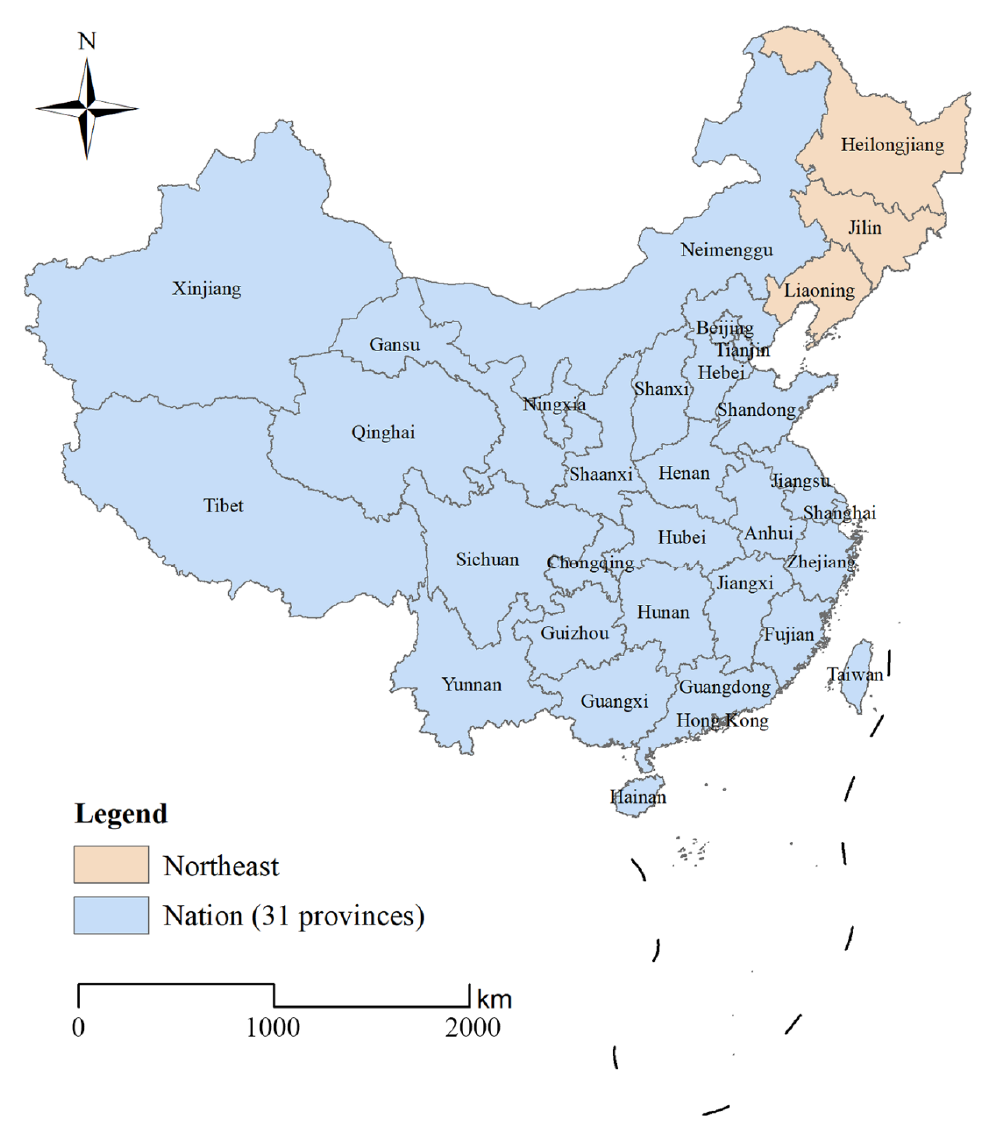
Figure 1. Grain production in different provinces of China and the main producing areas (Northeast